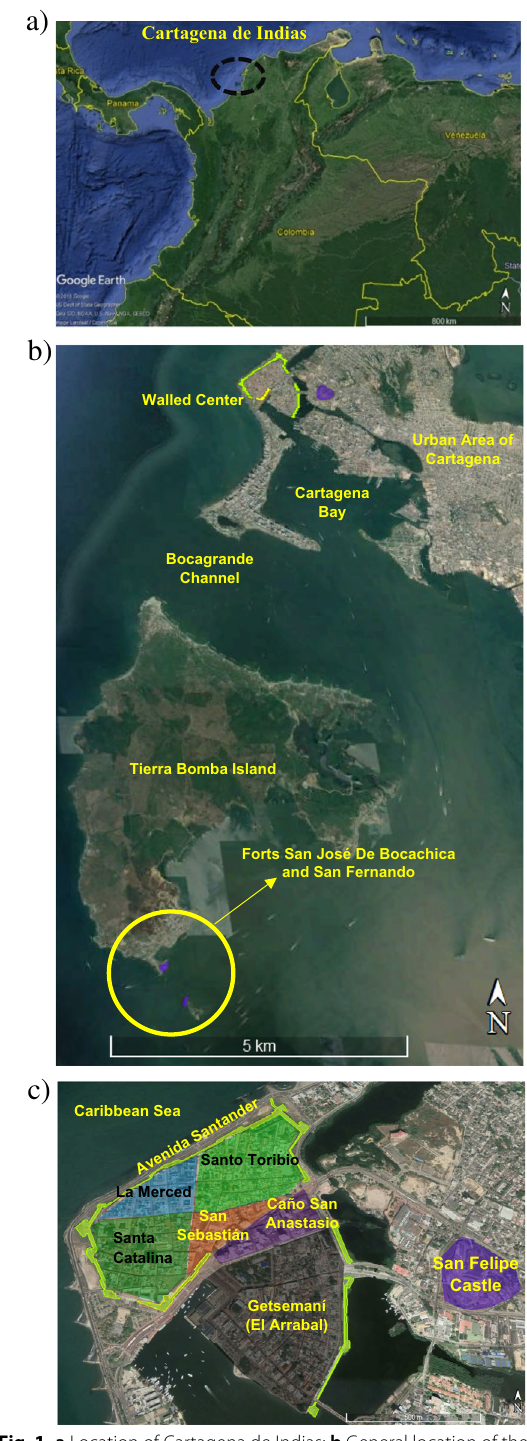
Fig. 1 a Location of Cartagena de Indias; b General location of the study area; c Location of the walled center and the castle of San Felipe, (In yellow the perimeter of the currently existing walls). Source: Adapted from Google Earth